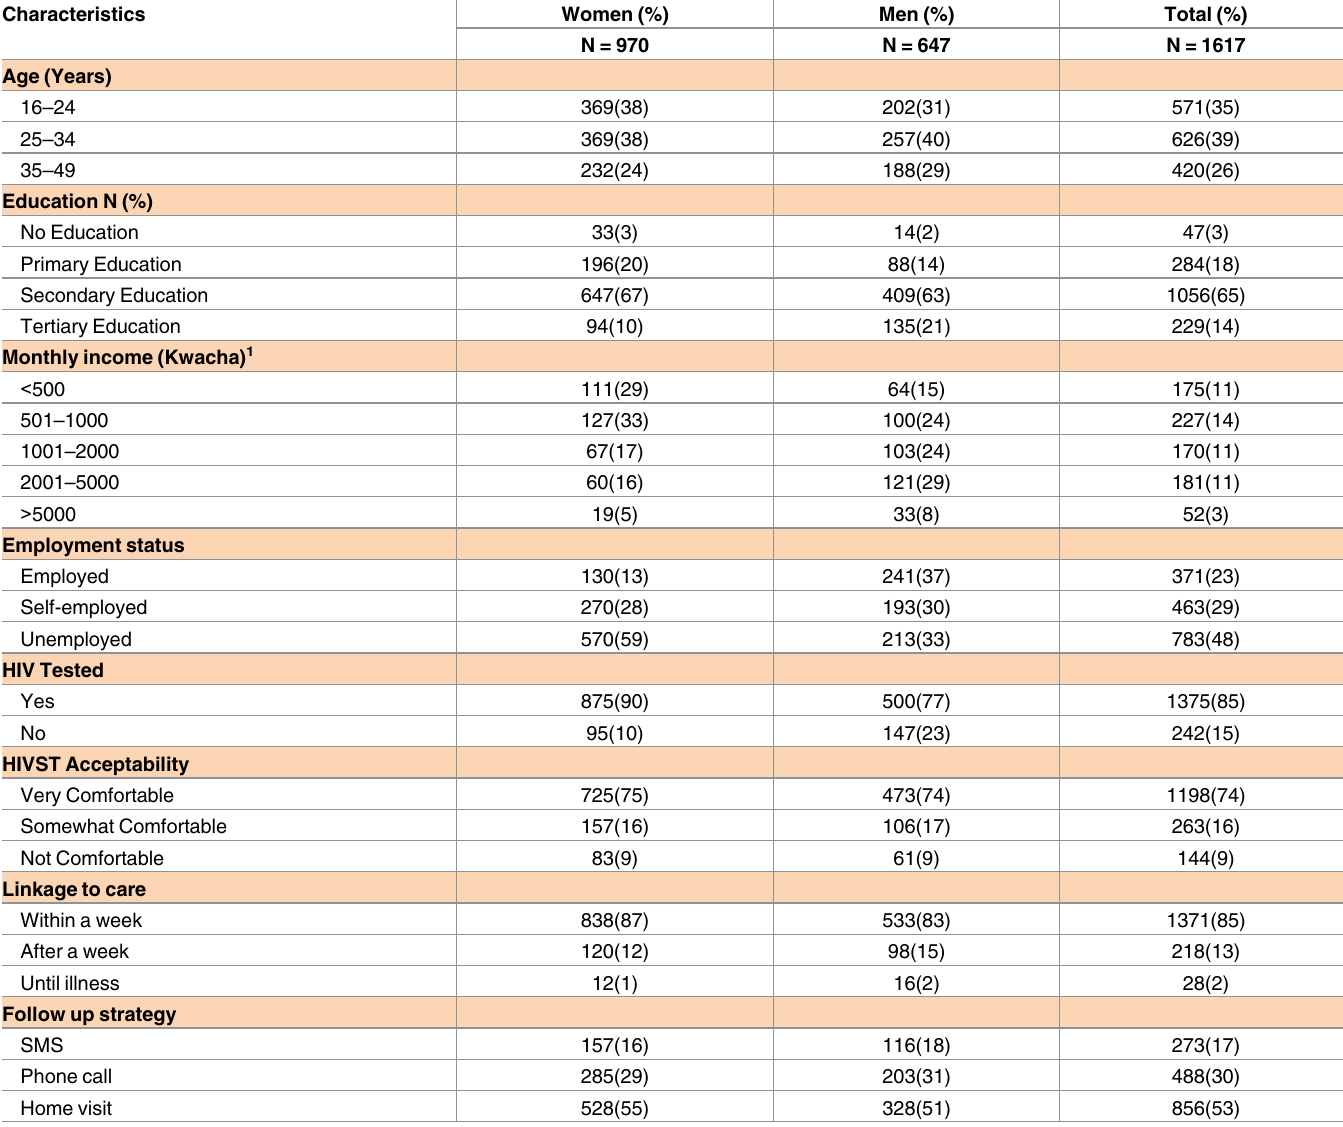
Table 1. Characteristics of and reported linkage to care, and follow up strategyamong respondents aged 16–49 yearsin Lusaka province, Zambia.